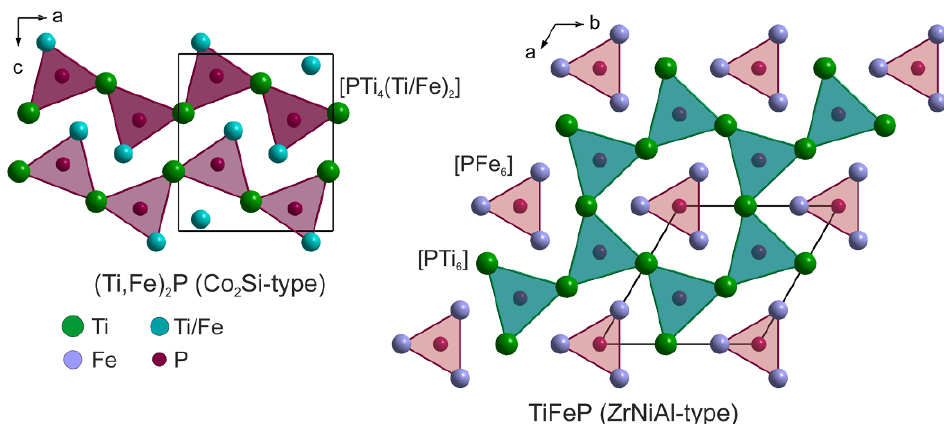
Figure 9. Packing of trigonal prisms in the Ti Table 7. Crystal data and structure refinement parameters for the Ti